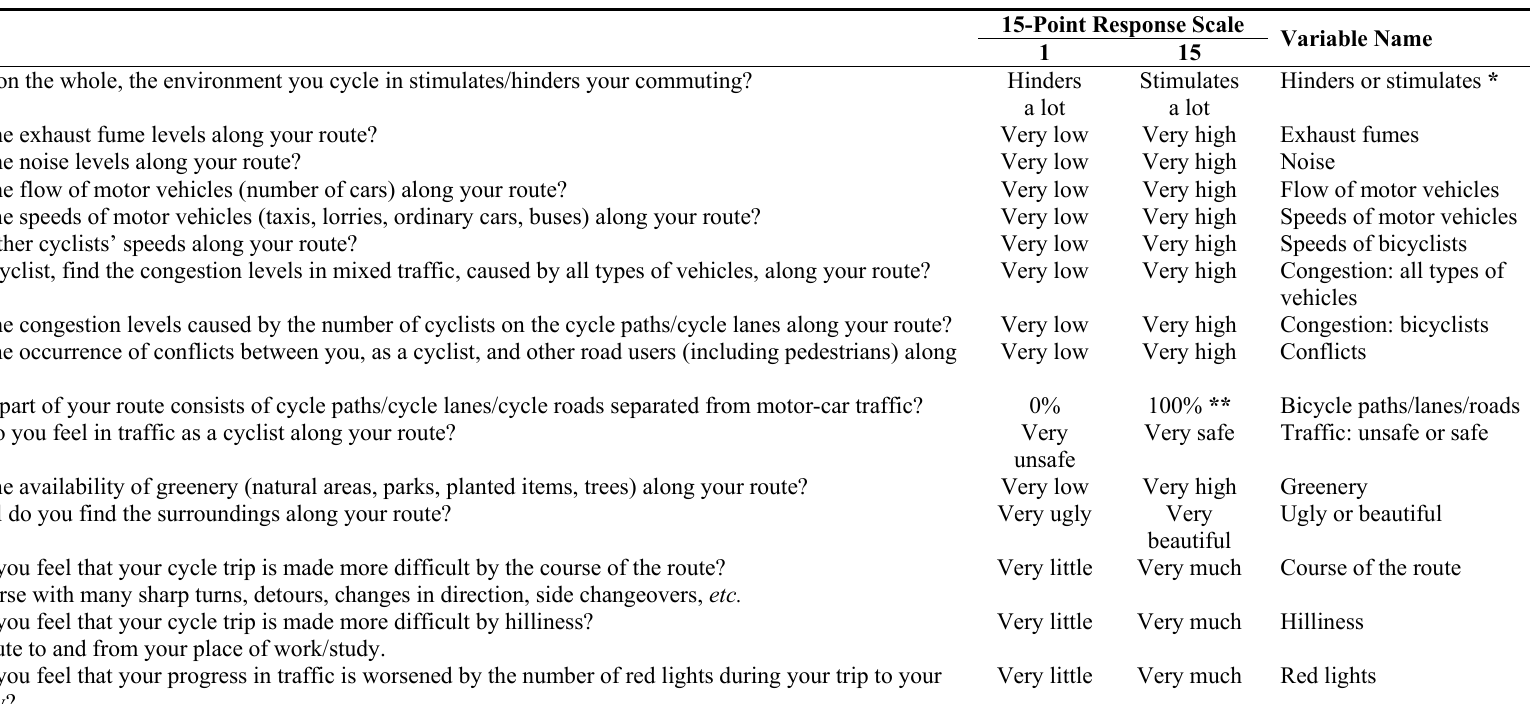
Table 2. The Active Commuting Route Environment Scale (ACRES) assessing bicyclists’ perceptions and